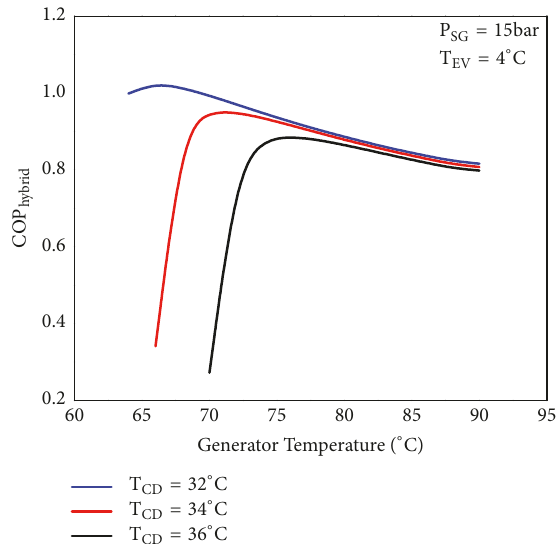
Figure 8: 𝐶𝑂𝑃 of hybrid and conventional cycle vs . evaporator temperature, 𝑇 𝐸𝑉 .